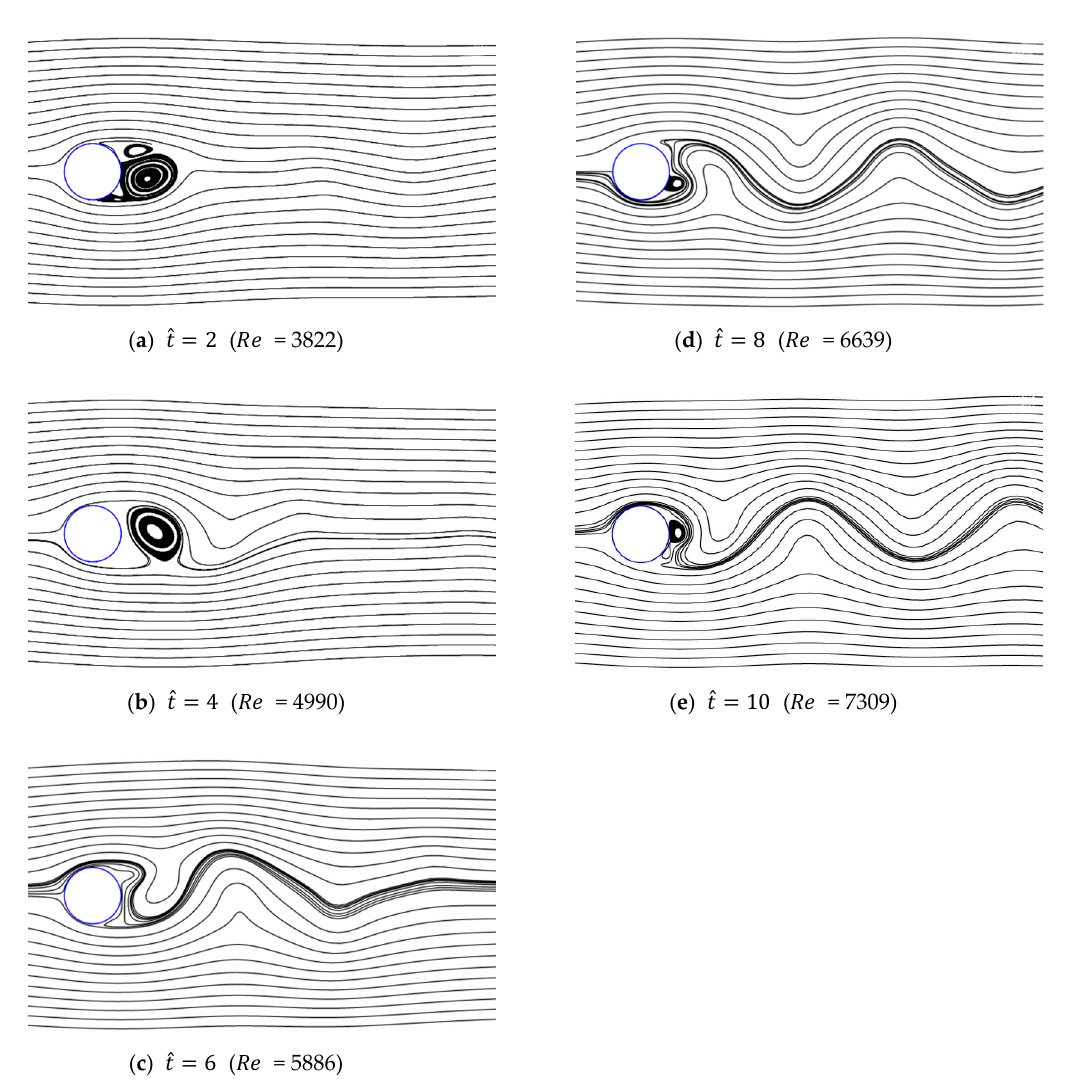
Figure 26. Streamlines around circular cylinder ( a / g = 0.1, Re 0 = 1000 )